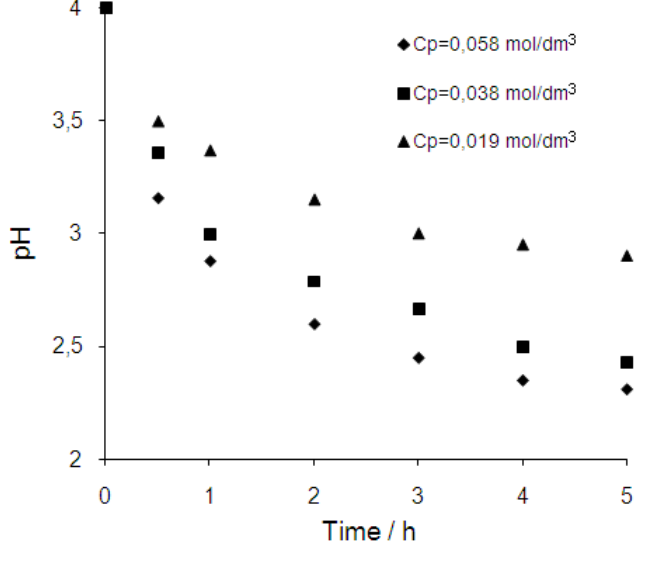
Figure 8. Variation of the feed phase pH with time of